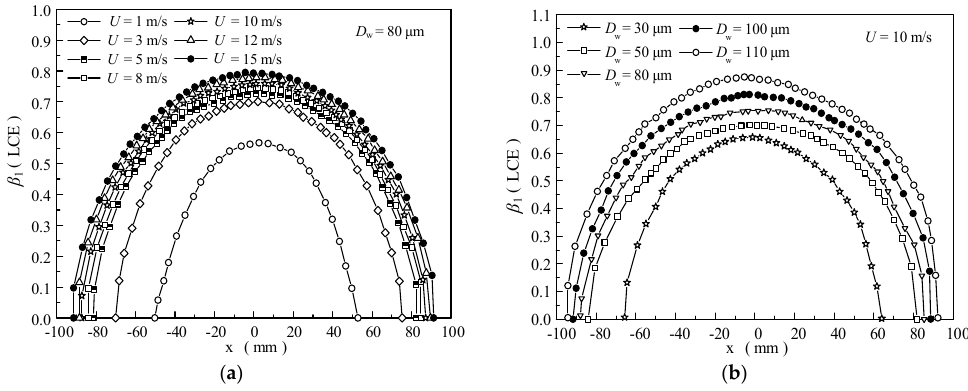
Figure 4. The collision efficiency β 1 on insulator (type A) edge under different environmental conditions: ( a ) Different wind speeds U and ( b ) different MVDs.